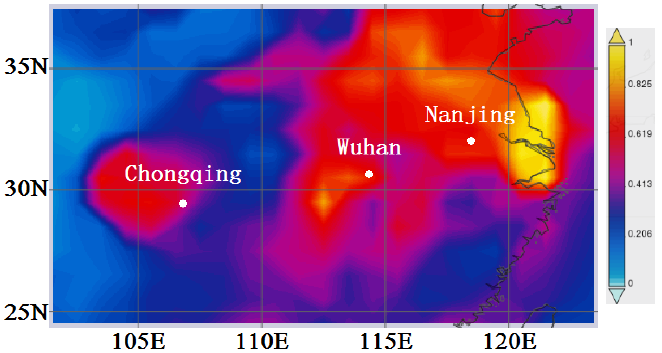
Figure 1. Aerosol optical depth (AOD) map of area-averaged time series over the Yangtze River Basin in China derived from MODIS-Aqua data from 1 September 2015 to 31 August 2016. Three white solid circles denote the cities of Chongqing, Wuhan, and Nanjing, respectively. Table 1. Basic Information of the three studied cities by the end of 2016. Source: statistical bulletin on national economic and social development, cited from the web of http://www.stats.gov.cn/tjsj/.